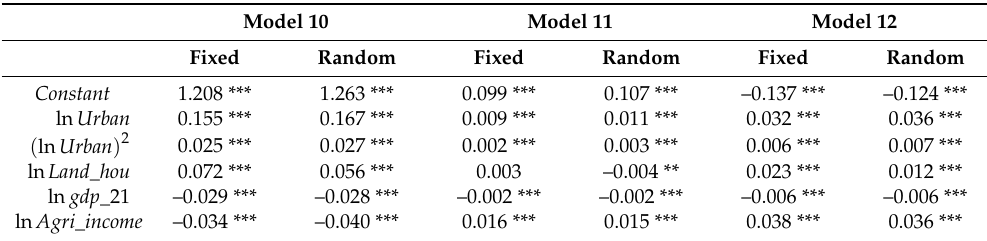
Table 4. Robustness tests